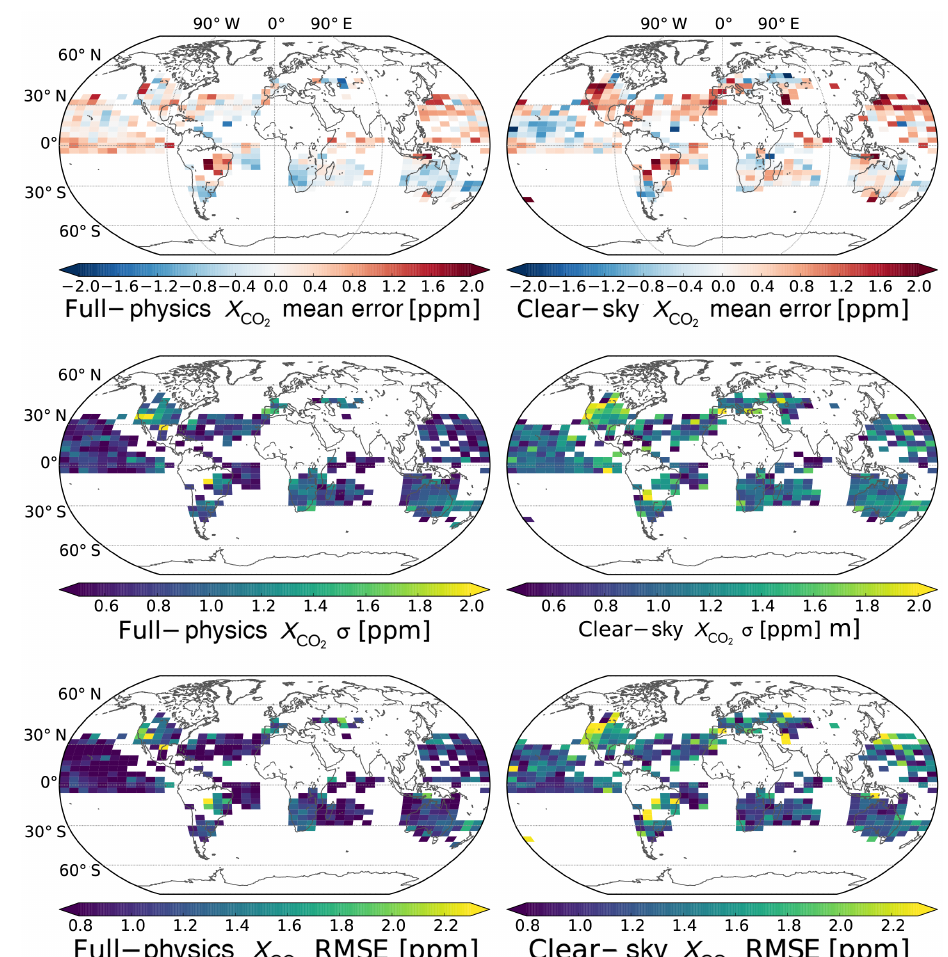
Figure 9. GOSAT full-physics (left column) and clear-sky (right column) retrieval mean X CO X CO errors (middle row), and X CO RMSEs (bottom row) for 8 ◦ × 4 ◦ (longitude × latitude) bins for a throughput of 2 2